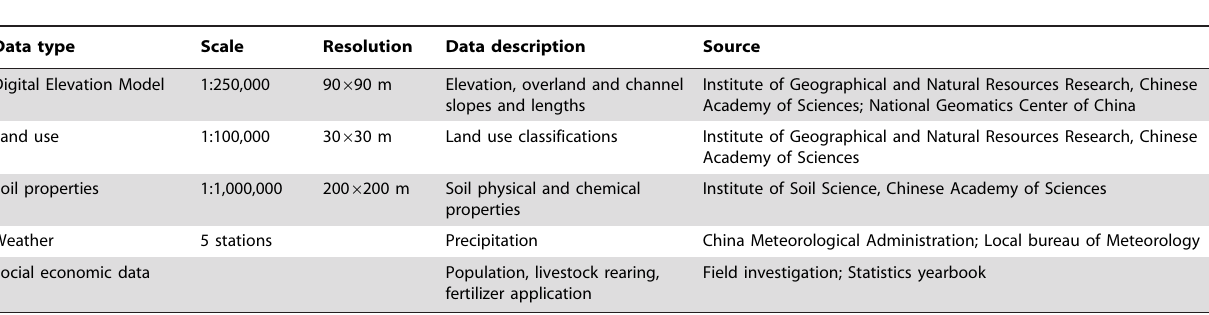
Table 1. The type and sources of available data in the Yulin